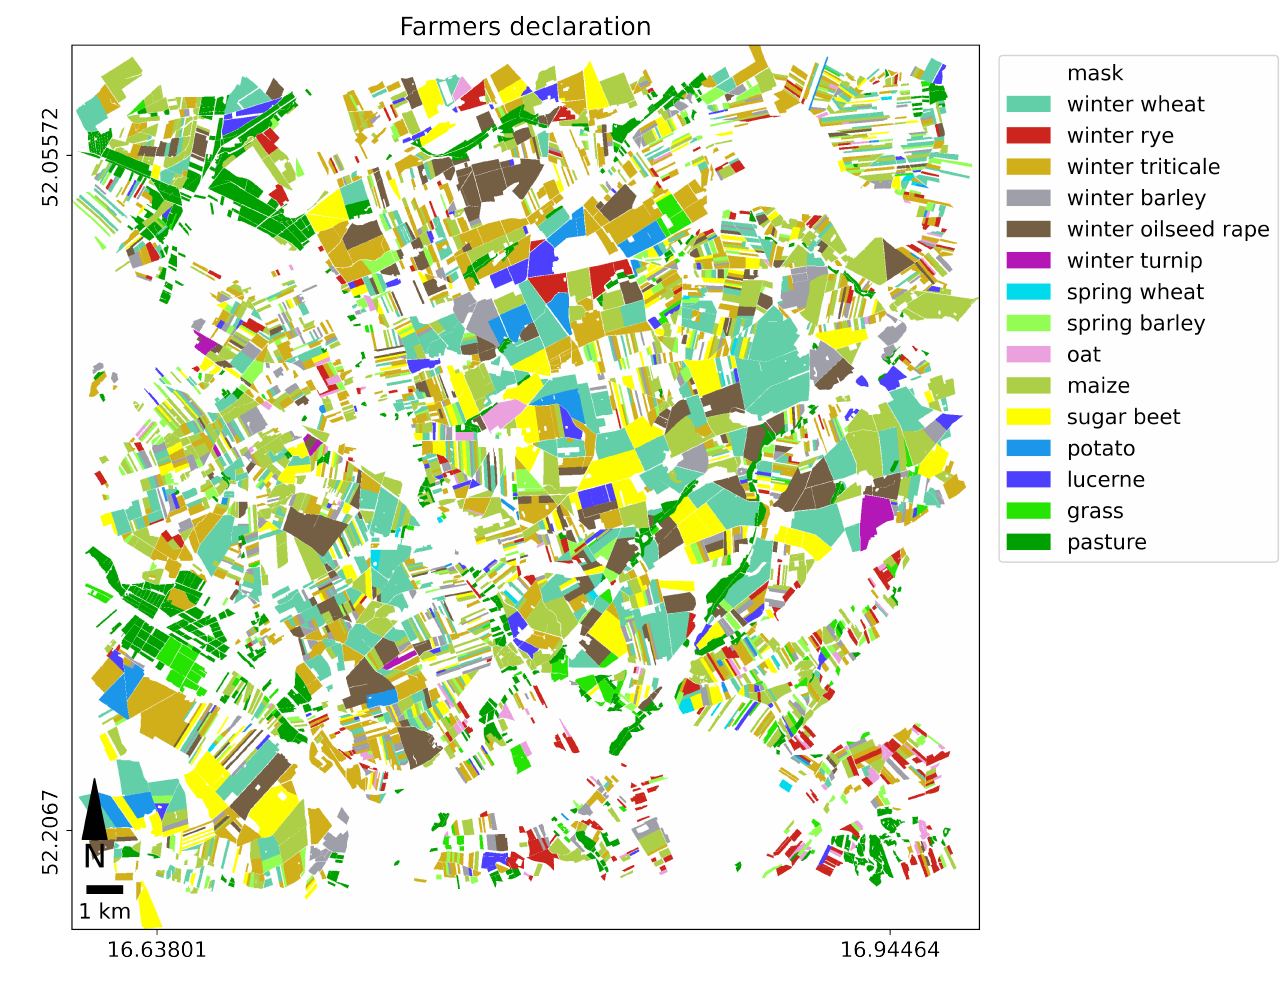
Figure 3. Declared agricultural parcels. Table 1. Crops declared for agriculture parcels (area in